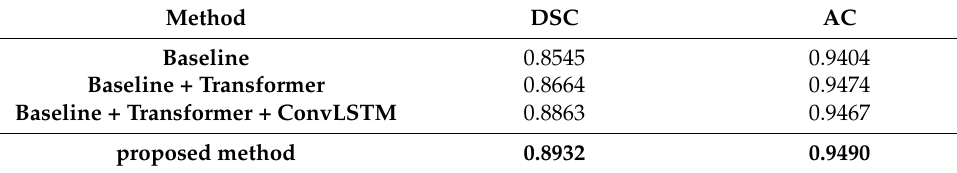
Table 5. Contribution of each of the proposed modules on the model